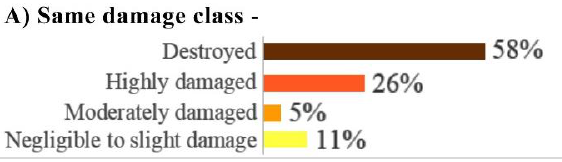
Figure 13. Percentage of buildings that had same damage class assessed in both 1 st and 2 nd method.